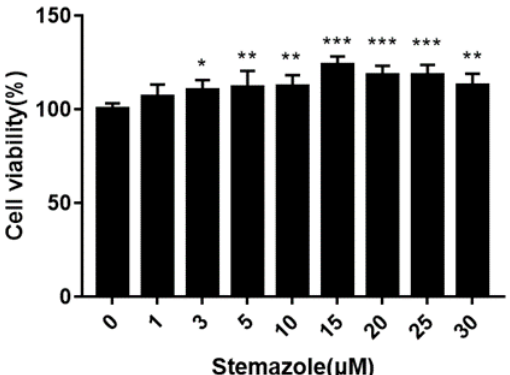
Figure 1. OPCs were treated with stemazole for 4 days, and the effects were analyzed with a Cell Titer-Glo luminescent cell viability assay. Stemazole promotes cell viability in OPCs. Untreated cells were used as the control (100%). Data represent the means ± SD (n = 6 duplicates), * p < 0.05, ** p < 0.01, *** p < 0.001. vs. 0 μM group.